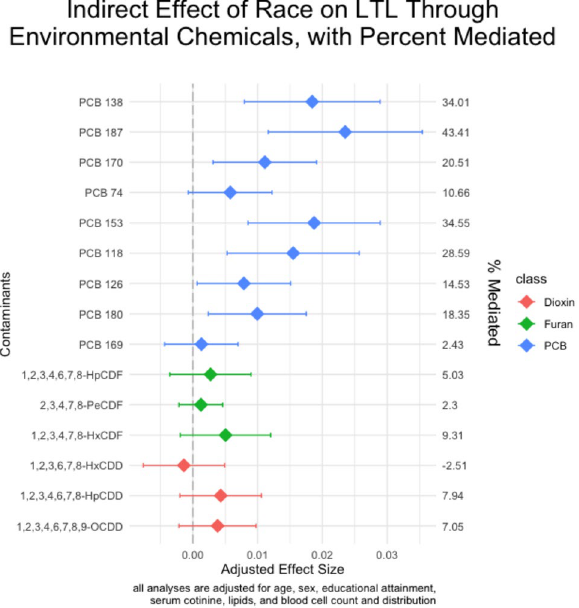
Figure 4. Results of the indirect effect of self-reported Black race on leukocyte telomere length through environmental chemicals. Point estimates and 95% confidence intervals are shown.